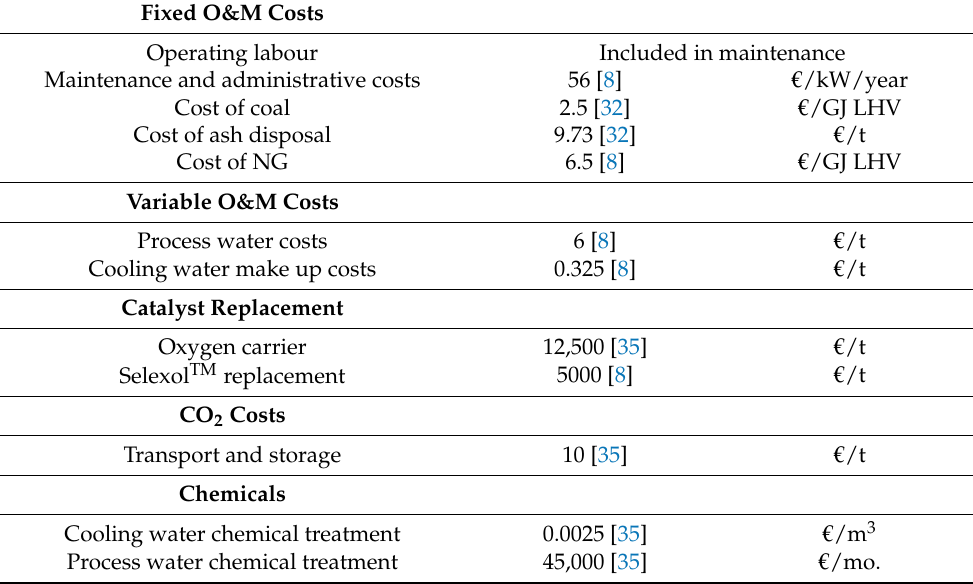
Table 4. Fixed and variable operating & maintenance cost assumptions for the GSC